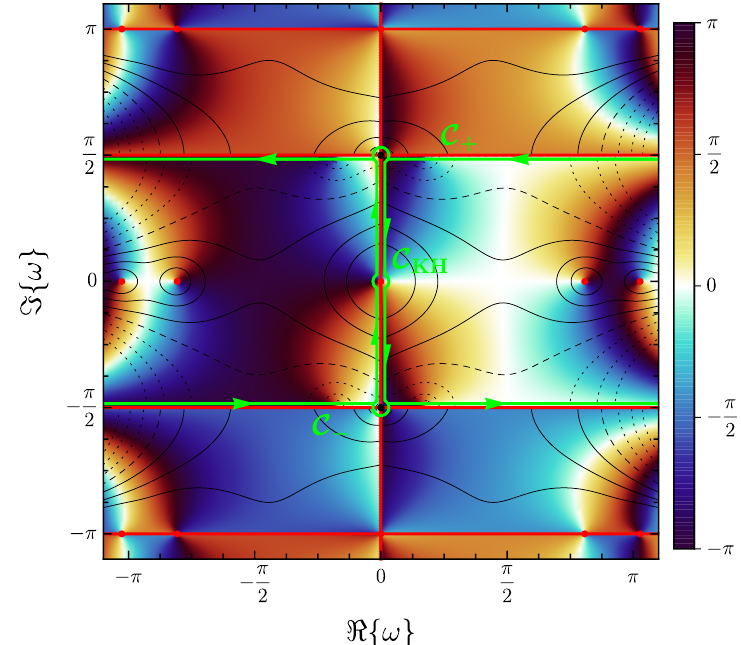
Figure 15: Complex structure of the contour integrand in the hyperbolic ω - (cid:3) / ] − ln (cid:2) Φ 2 plane for the alternating sum over ln [ 2 Γ 2, together with the contour m m C = C + + C − + C . The contributions from the contours C ± vanish due to their sym- KH metry and only the non-trivial keyhole contour C is relevant for the correction to KH the behaviour of the open surfaces. For the colour coding see Fig.